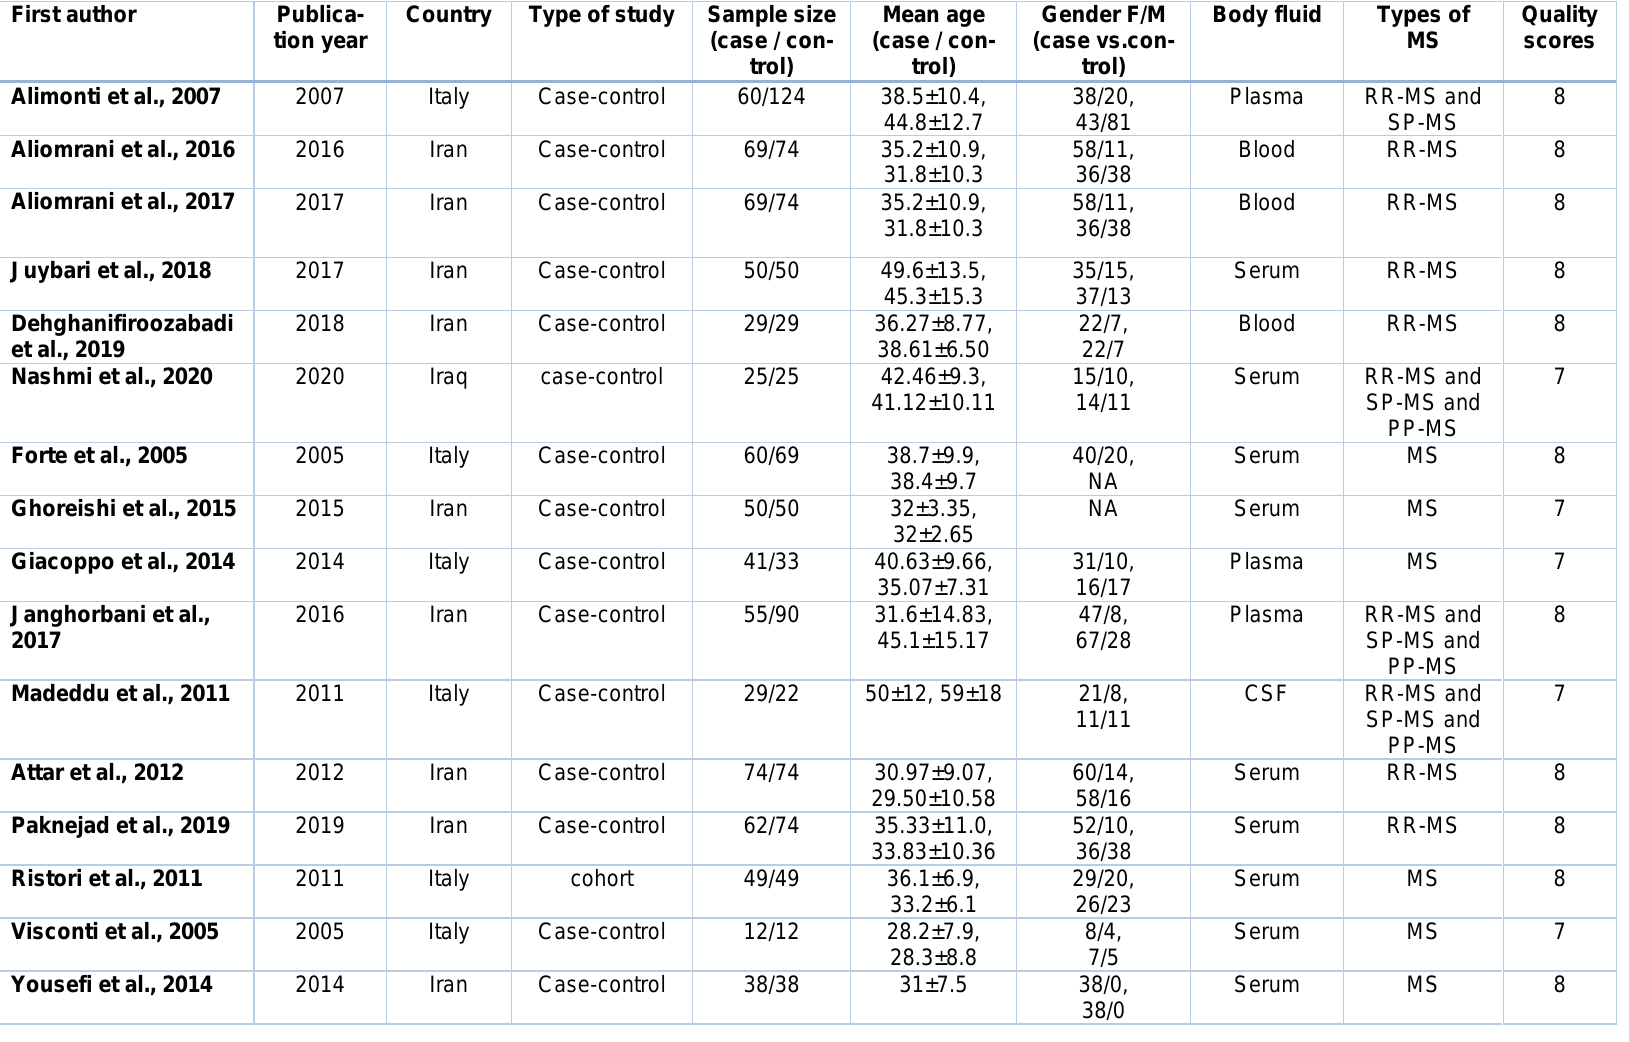
Table 1: Main characteristics of included